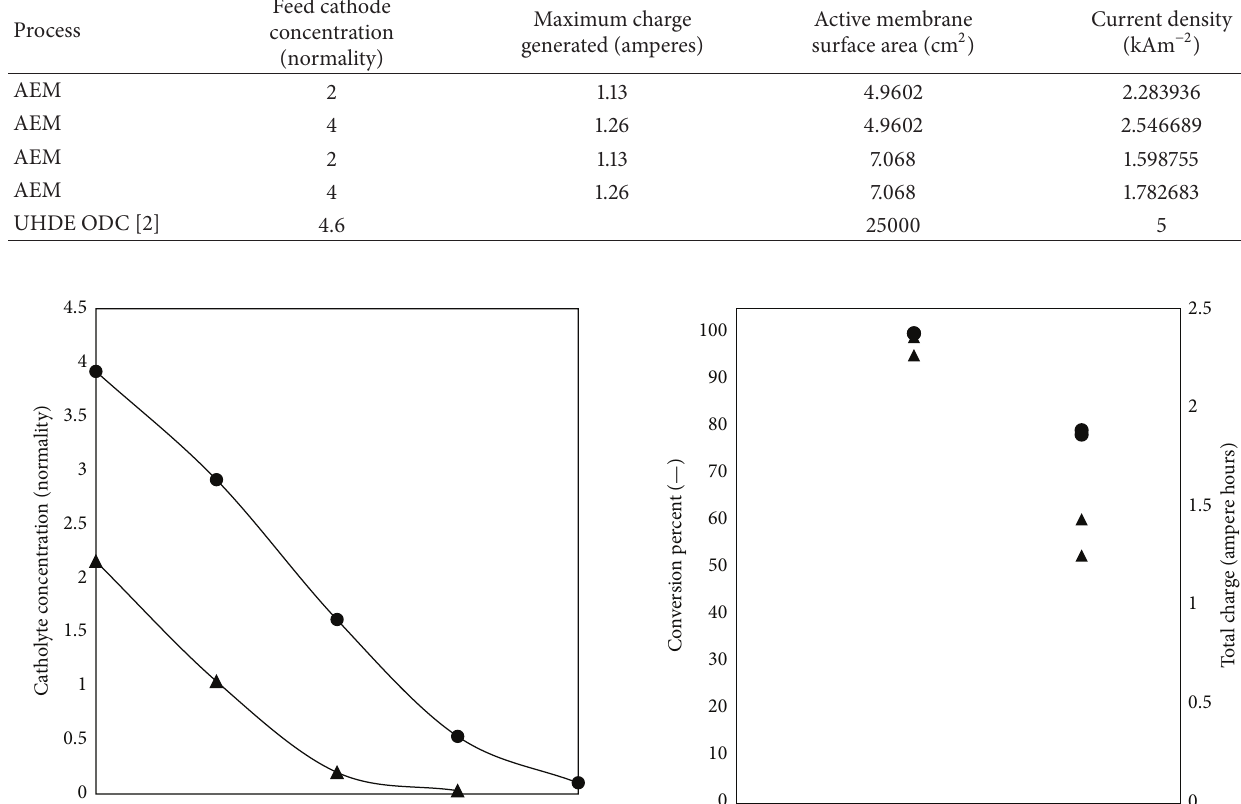
Table 4: Current density values for different feed concentrations and UHDE ODC process.